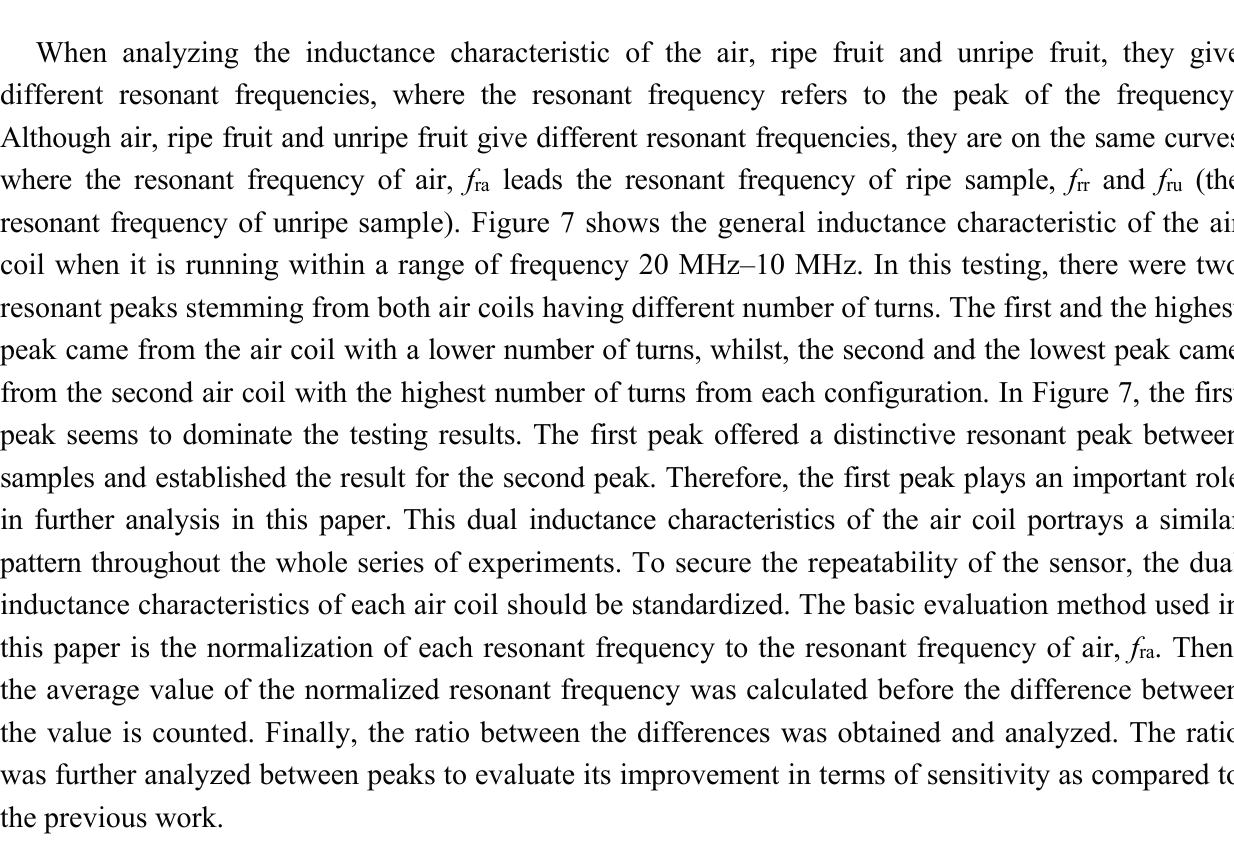
Figure 7. Inductance characteristics of the oil palm fruit